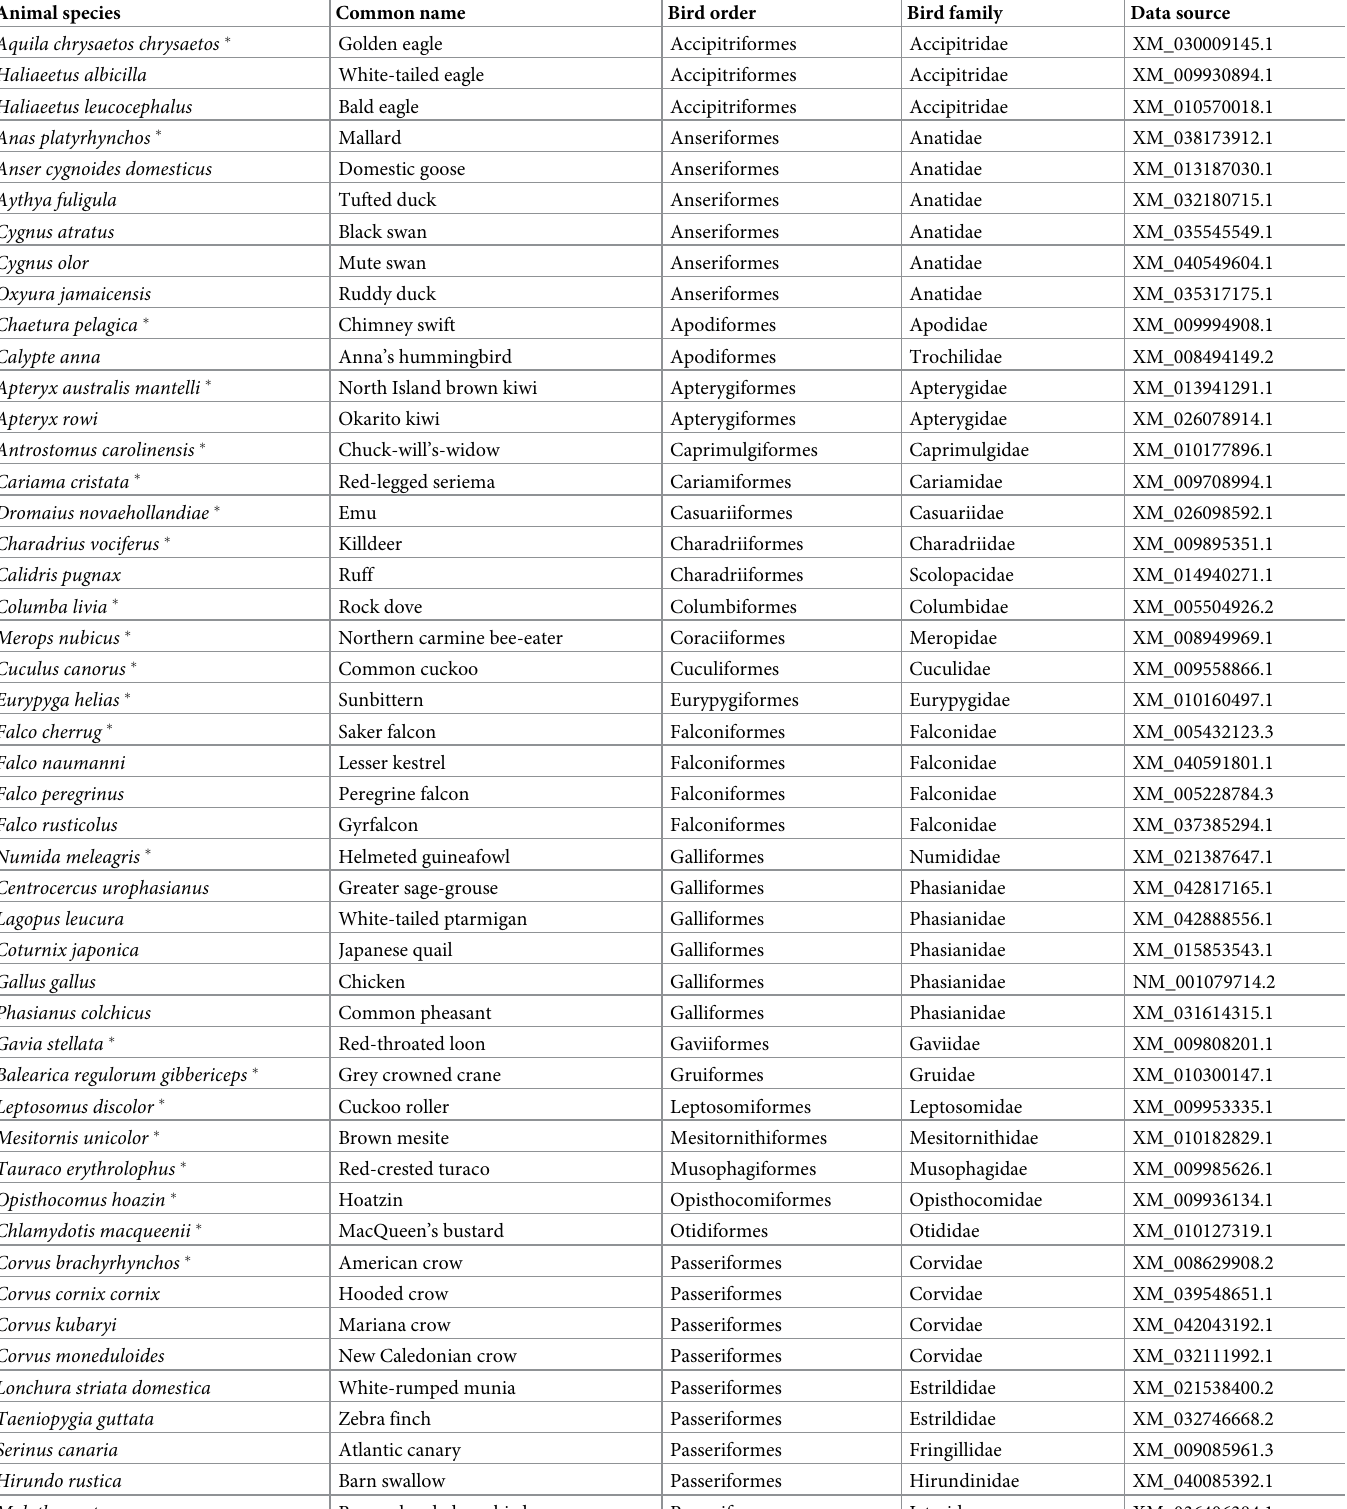
Table 1. Overview of collagen 1 α 2 data sources. The species marked with an asterisk were included in the common bird ancestor estimation. Animal